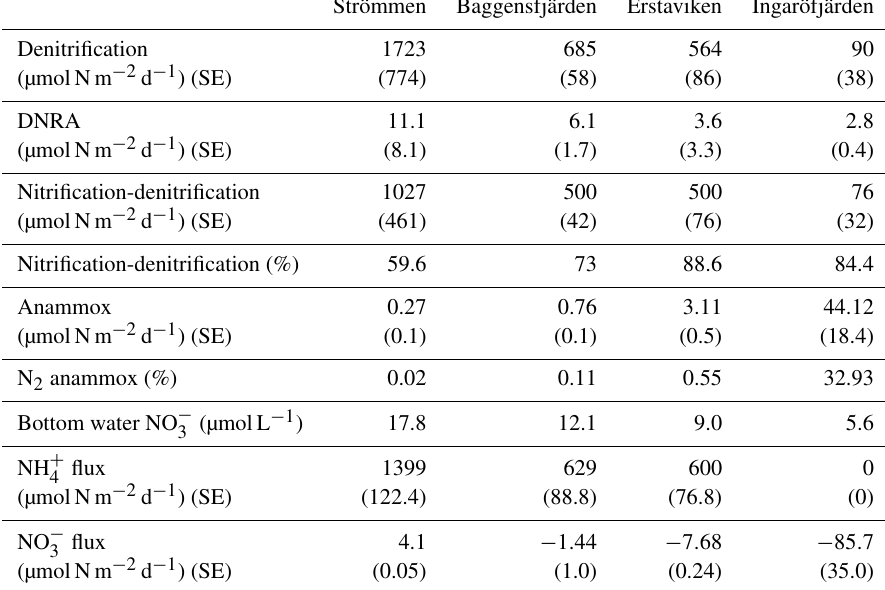
Table 5. Areal rates of benthic NO − of denitrification supported by NO − and NO − fluxes from the surface sediments into the water column (calculated from pore water profiles), including standard error (SE), are 3